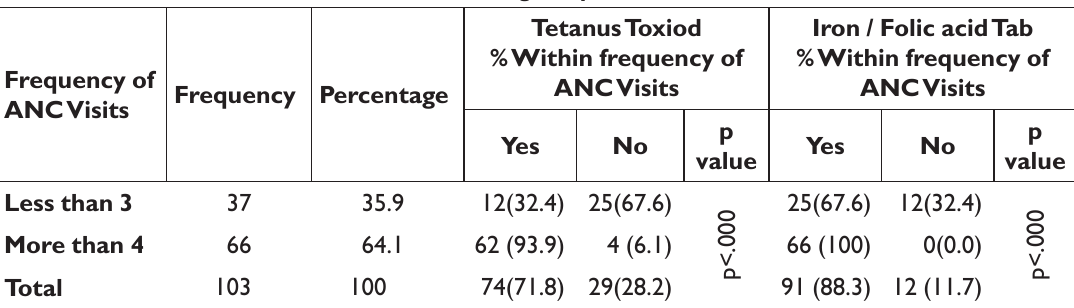
Ante Natal Care Visits and Frequency Distribution of Women who Obtained Tetanus Toxoid and Iron/Folic Acid Tablets in Last Pregnancy